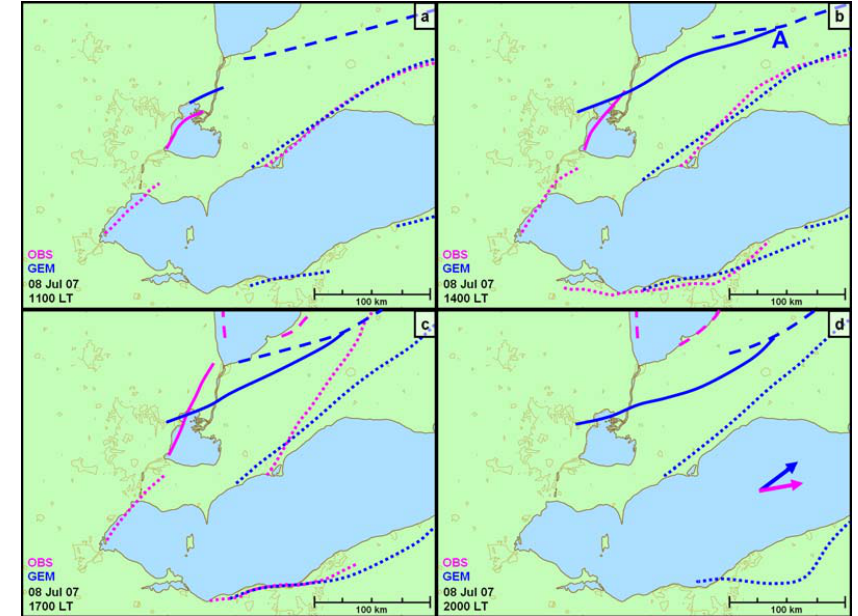
Figure 10. Same as in Fig. 8 but for July 8 th , 2007. Location A is referred to in the text. 3 Fig. 10. Same as in Fig. 8 but for 8 July 2007. Location A is referred to in the